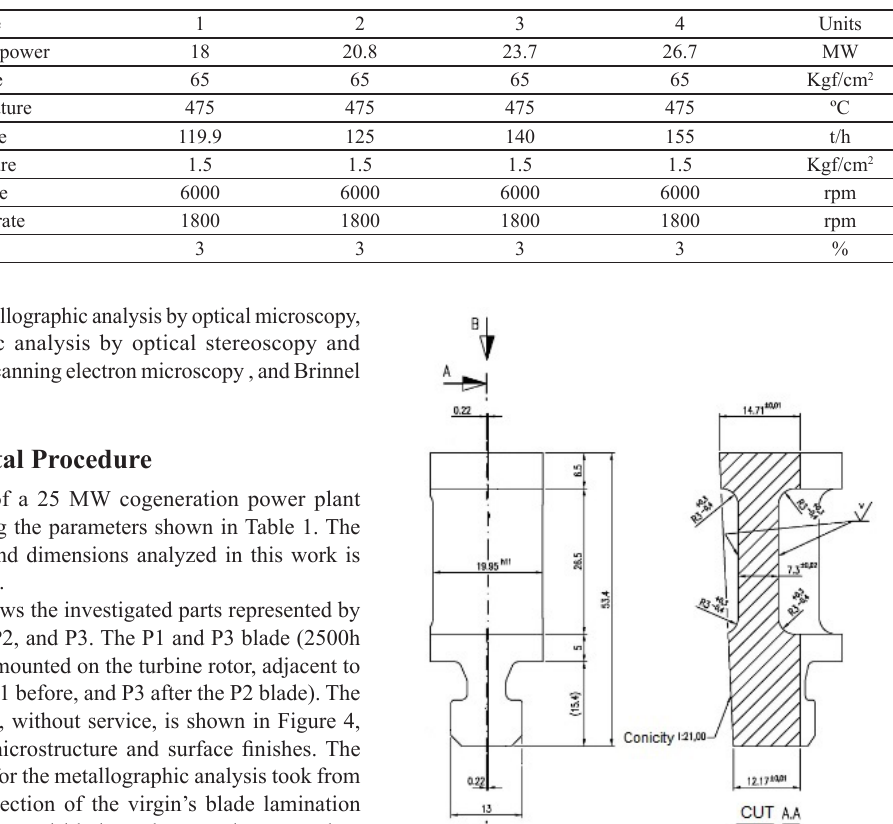
Figure 1. Schematic of fretting fatigue damage and failure mechanism 10 . Table 1. Turbine operational parameters.